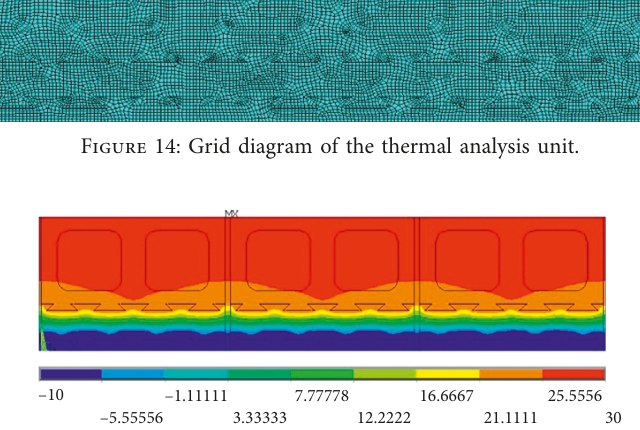
Figure 15: Cloud pattern of wall temperature distribution.